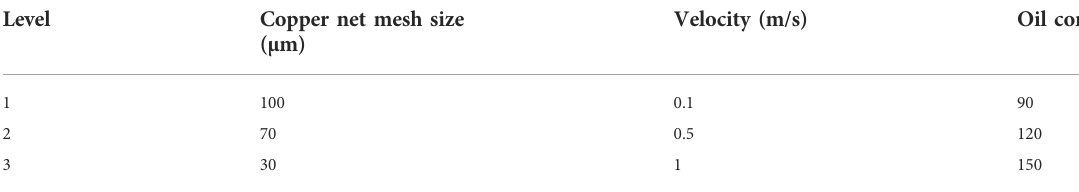
TABLE 2 Factor levels in the orthogonal experiment.